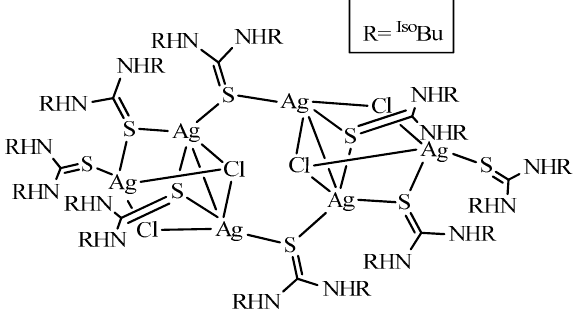
Figure 3. Silver cluster, 3